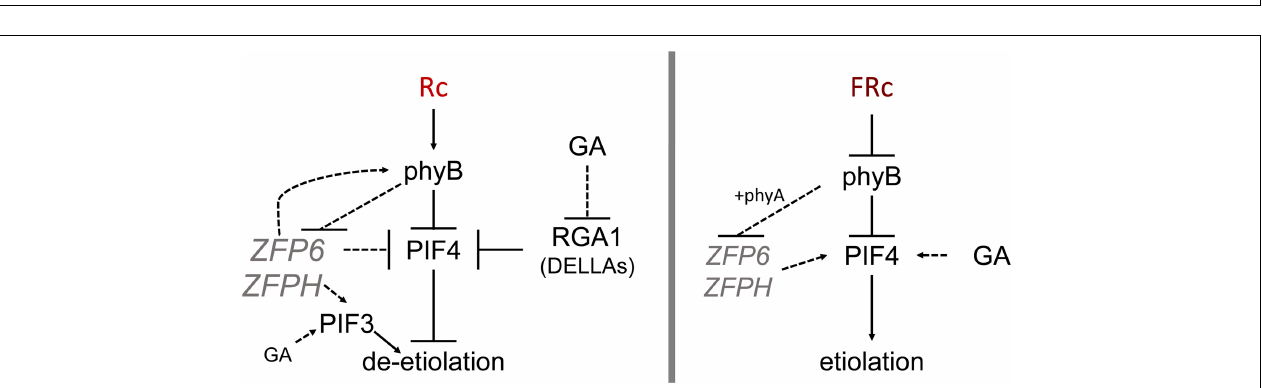
FIGURE 7 | Promoter analyses for ZFP6 and ZFPH genes. The transcription start (TS) was identified using the neural network promoter prediction website and the putative light-responsive promoter regions were found using the PlantCare database (see text for details). Numbers indicate the motif and start codon positions. Sequence of the motif and the strand of DNA on which it is found (–, negative; + , positive) is indicated in the table.